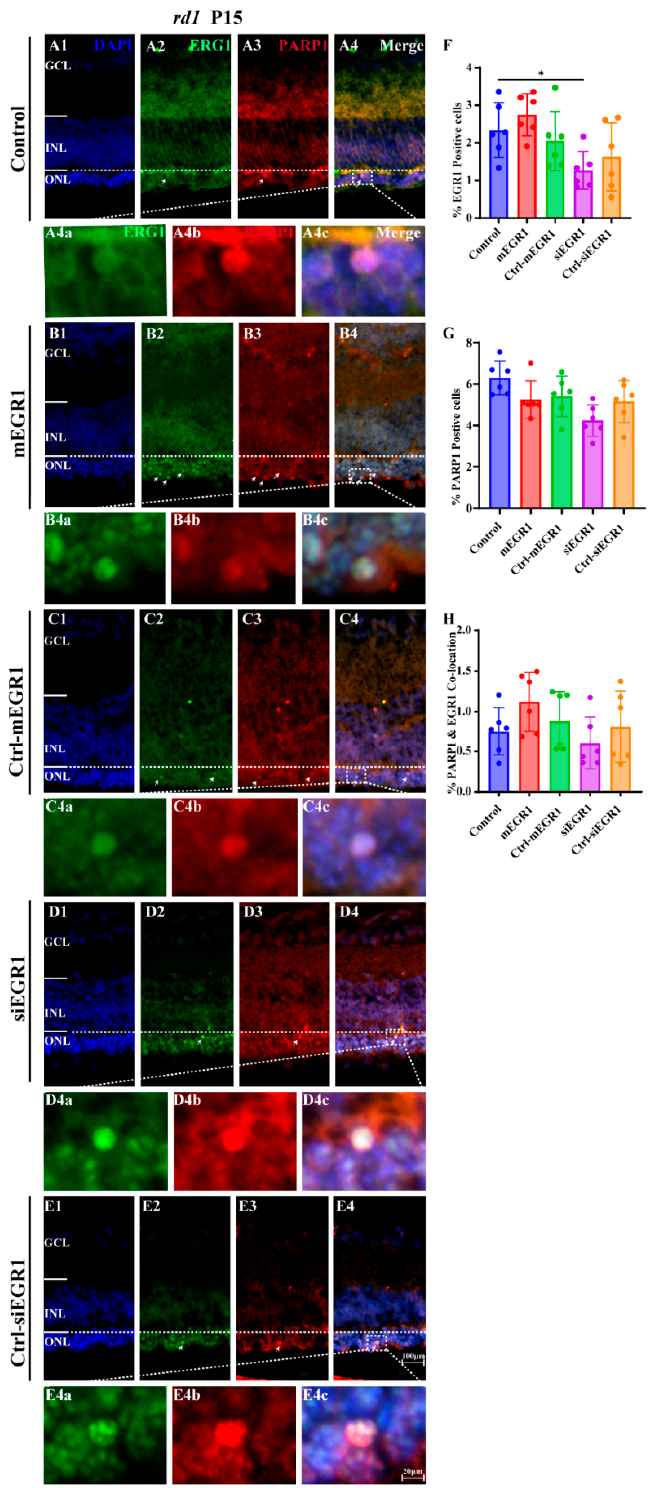
Figure 5. EGR1 and PARP1 expression colocalize in rd1 photoreceptors. At P5, rd1 mice were given a single suprachoroidal injection of AAV carrying constructs targeting EGR1. The expression of EGR1 (green) and PARP1 (red) was examined at P15 in rd1 retinas using immunofluorescence staining. ( A1 – A4 ) Untreated, control rd1 retina. ( B1 – B4 ) Retina after treatment with AAV9-EGR1-GFP (1.84 × 10 10 vg/mL). ( C1 – C4 ) Retina after treatment with a control construct for EGR1. ( D1 – D4 ) rd1 retina treated with siRNA construct AAV9-EGR1-RNAi (1.57 × 10 9 vg/mL). ( E1 – E4 ) Retina after treatment with a control construct for siRNA EGR1. The arrows indicate the colocalization cells of EGR1 and PARP1 positive cells. The colocalized sections (merge, A4c,B4c,C4c,D4c,E4c ) show the